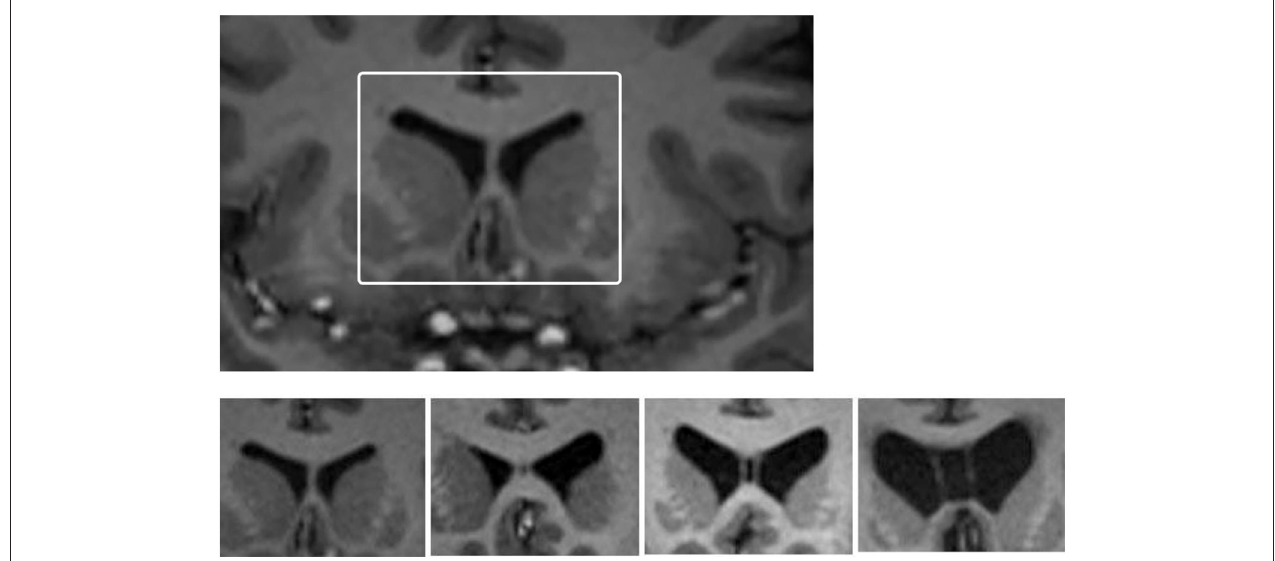
FIGURE 1 | Images of grades of CSP. Cavum septum pellucidum (CSP) grading system for grades encountered in this study. Top: White box depicts region that was enlarged to undertake CSP grading for each participant. Bottom: from left to right the four-image panel represents CSP grades of 0 (absent), 1 (slight), 2 (mild), and 3 (moderate). There were no grade 4 (severe) cases in this study.